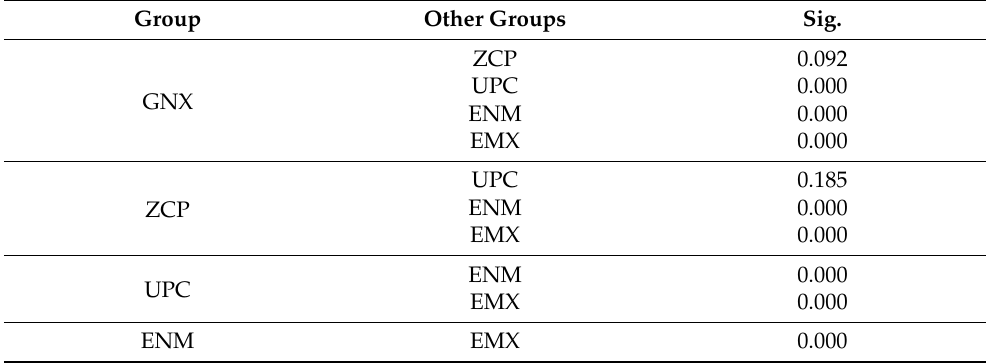
Table 6. Multiple comparisons between TP values for the non-aged groups. Shaded cells indicate significant differences p < 0.5. Group